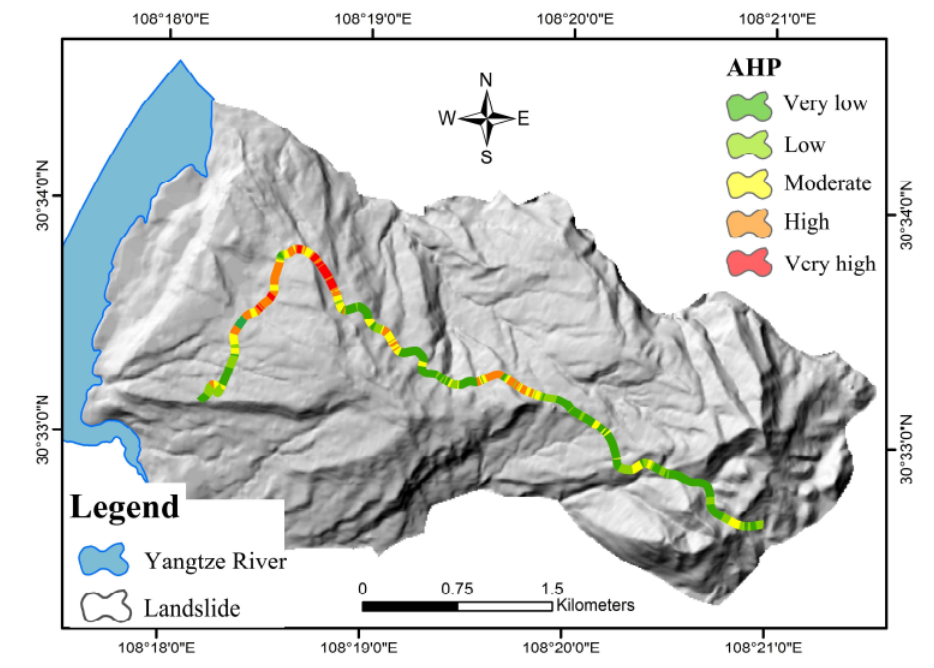
Figure 11. The G69 landslide susceptibility map based on AHP